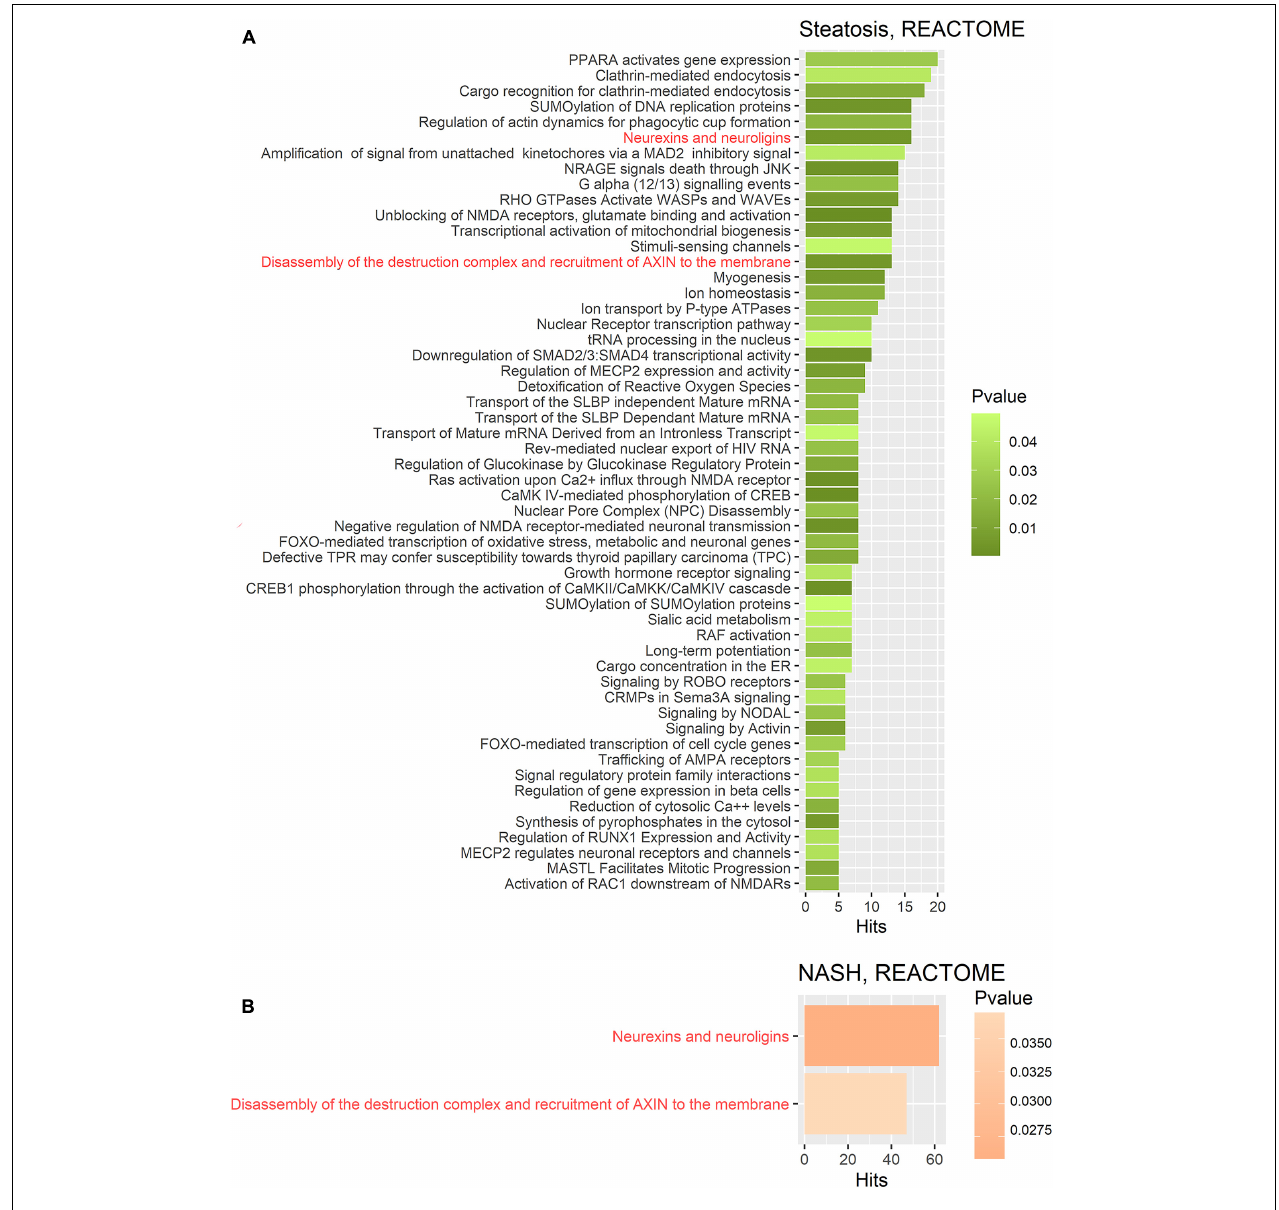
FIGURE 5 | Gene set enrichment analysis performed on the REACTOME metabolic pathway database on two gene sets. (A) Target gene set of miRNA that were significantly deregulated in the group of patients with steatosis ( p ≤ 0.05); (B) Target gene set of miRNA that were significantly deregulated in the group of patients with NASH ( p ≤ 0.05). The common pathways in steatosis and NASH are highlighted in red. Hits—number of target genes represented in the pathway.